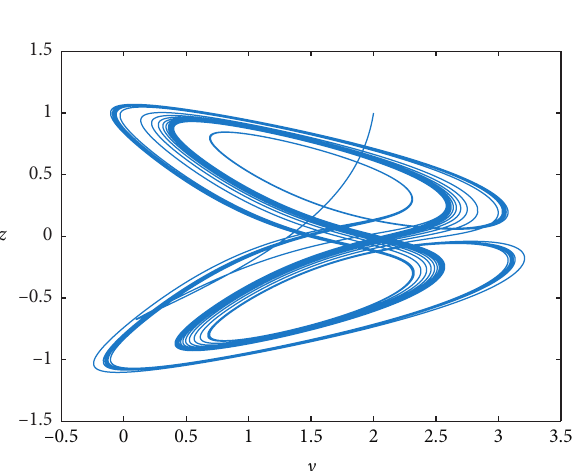
Figure 5: Dynamic behavior of fractional financial chaotic model with α � 0 . 95.